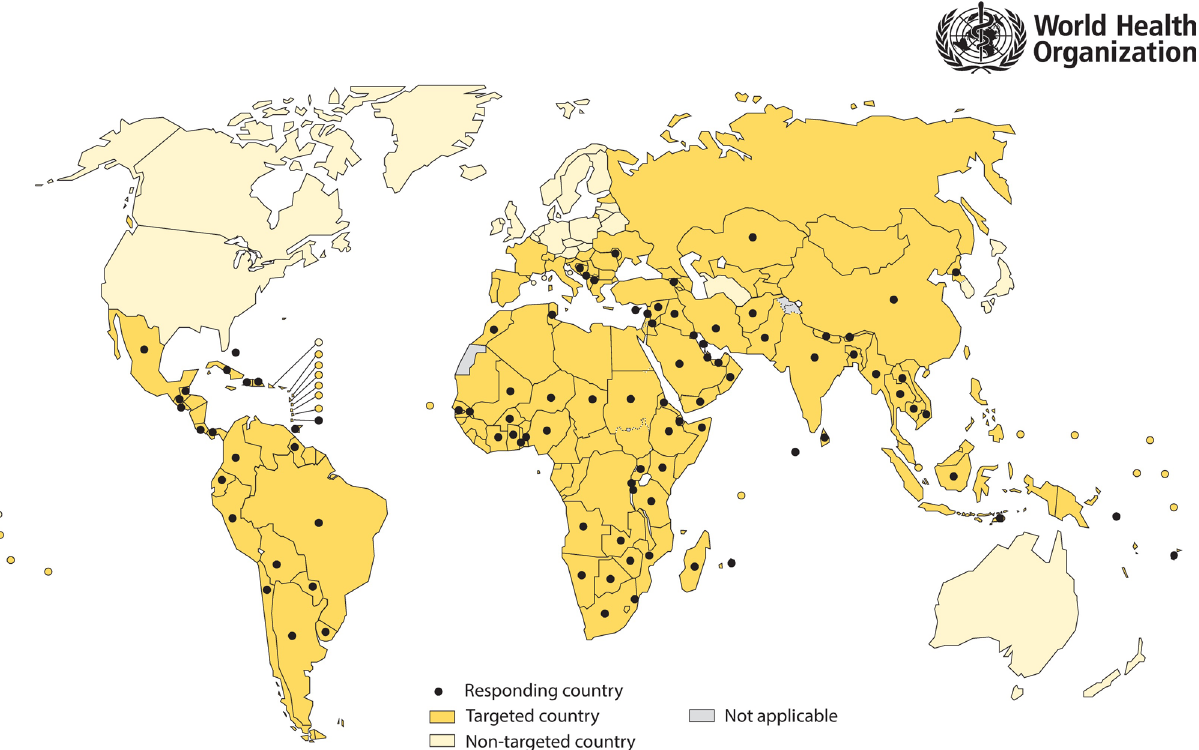
Figure 1. Map showing targeted and responding countries. The boundaries and names shown, and the designations used on this map do not imply the expression of any opinion whatsoever on the part of the World Health Organization concerning the legal status of any country, territory, city, or area or of its authorities, or concerning the delimitation of its frontiers or boundaries. Dotted lines on maps represent approximate border lines for which there may not yet be full agreement. Data source: World Health Organization (WHO). Map production: Control of Neglected Tropical Diseases, WHO. © WHO 2021. All rights reserved. Written permission to use and adapt the map was granted by